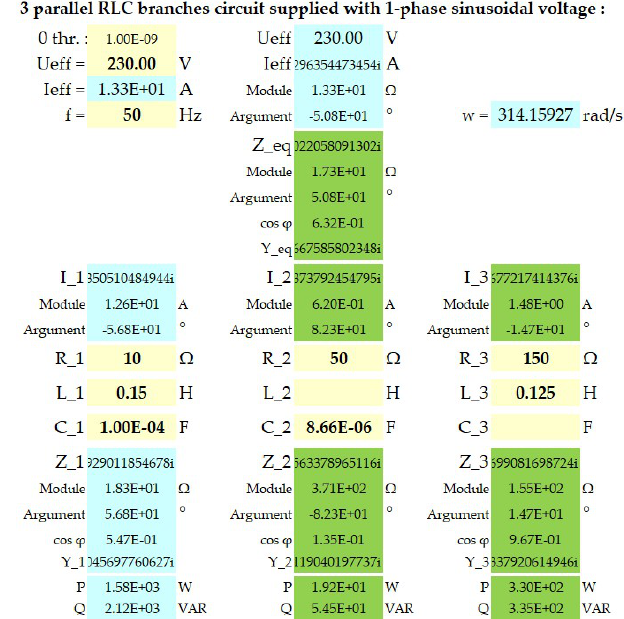
Figure 6. Three RLC branches connected in parallel circuit calculation